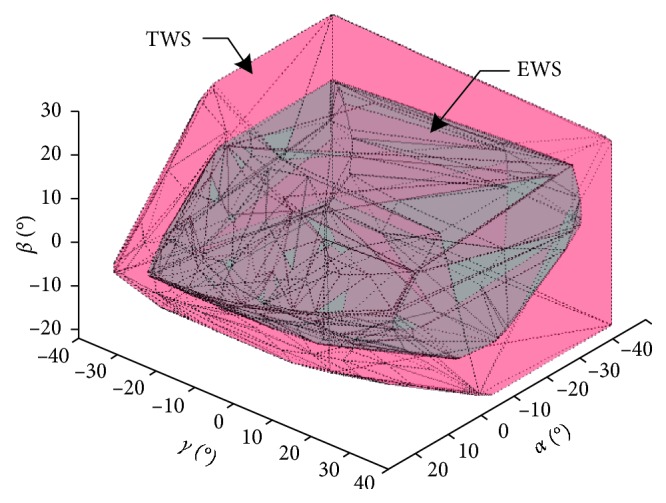
TWS and EWS of PARR.